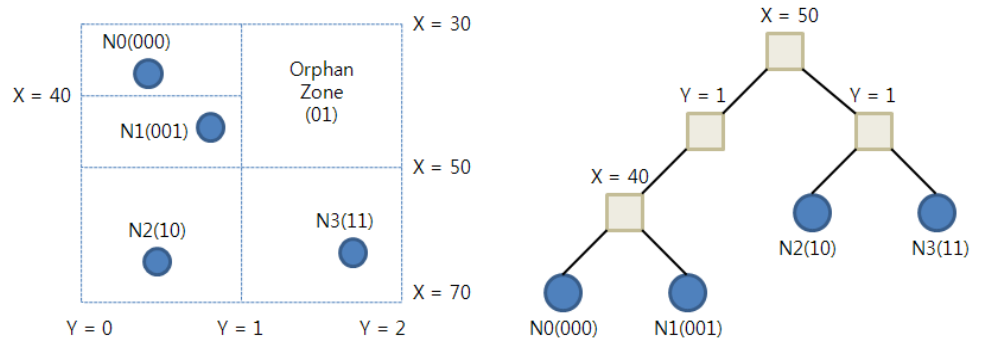
Figure 1. An example of